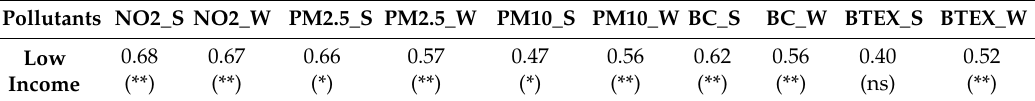
Table 4. Correlation between low income and pollutants in summer (_S) and winter (_W) with significance level 1